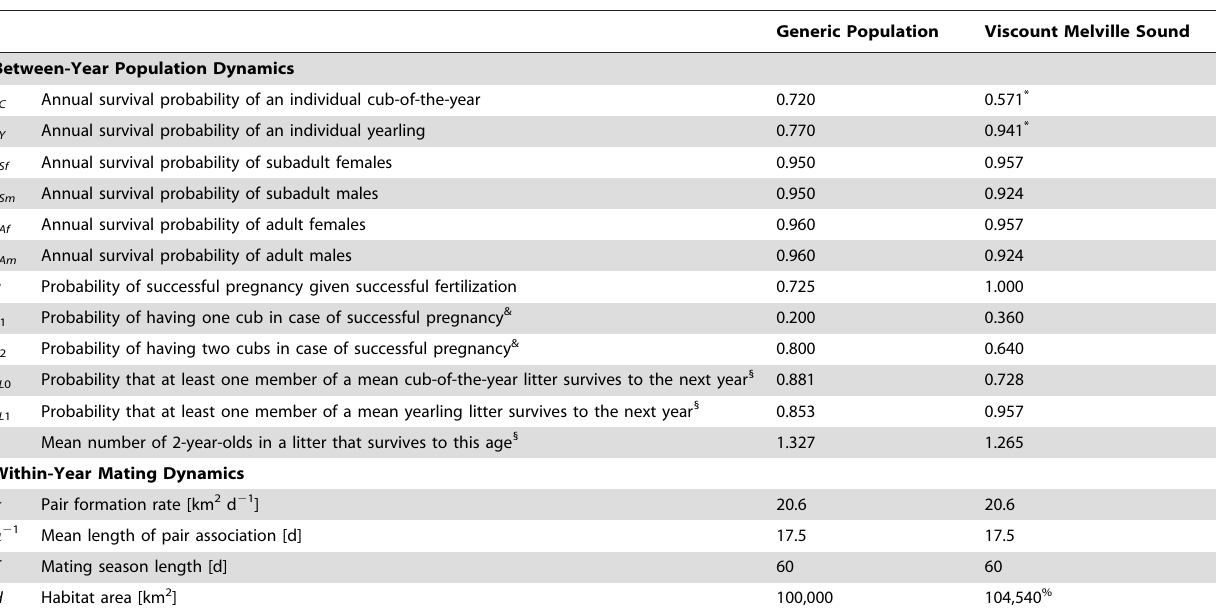
Table 1. Parameter definitions for the polar bear projection model given by equations 1–2 (between-year population dynamics) and equation 3 (within-year mating dynamics), with estimates given for a generic polar bear population and the Viscount Melville Sound